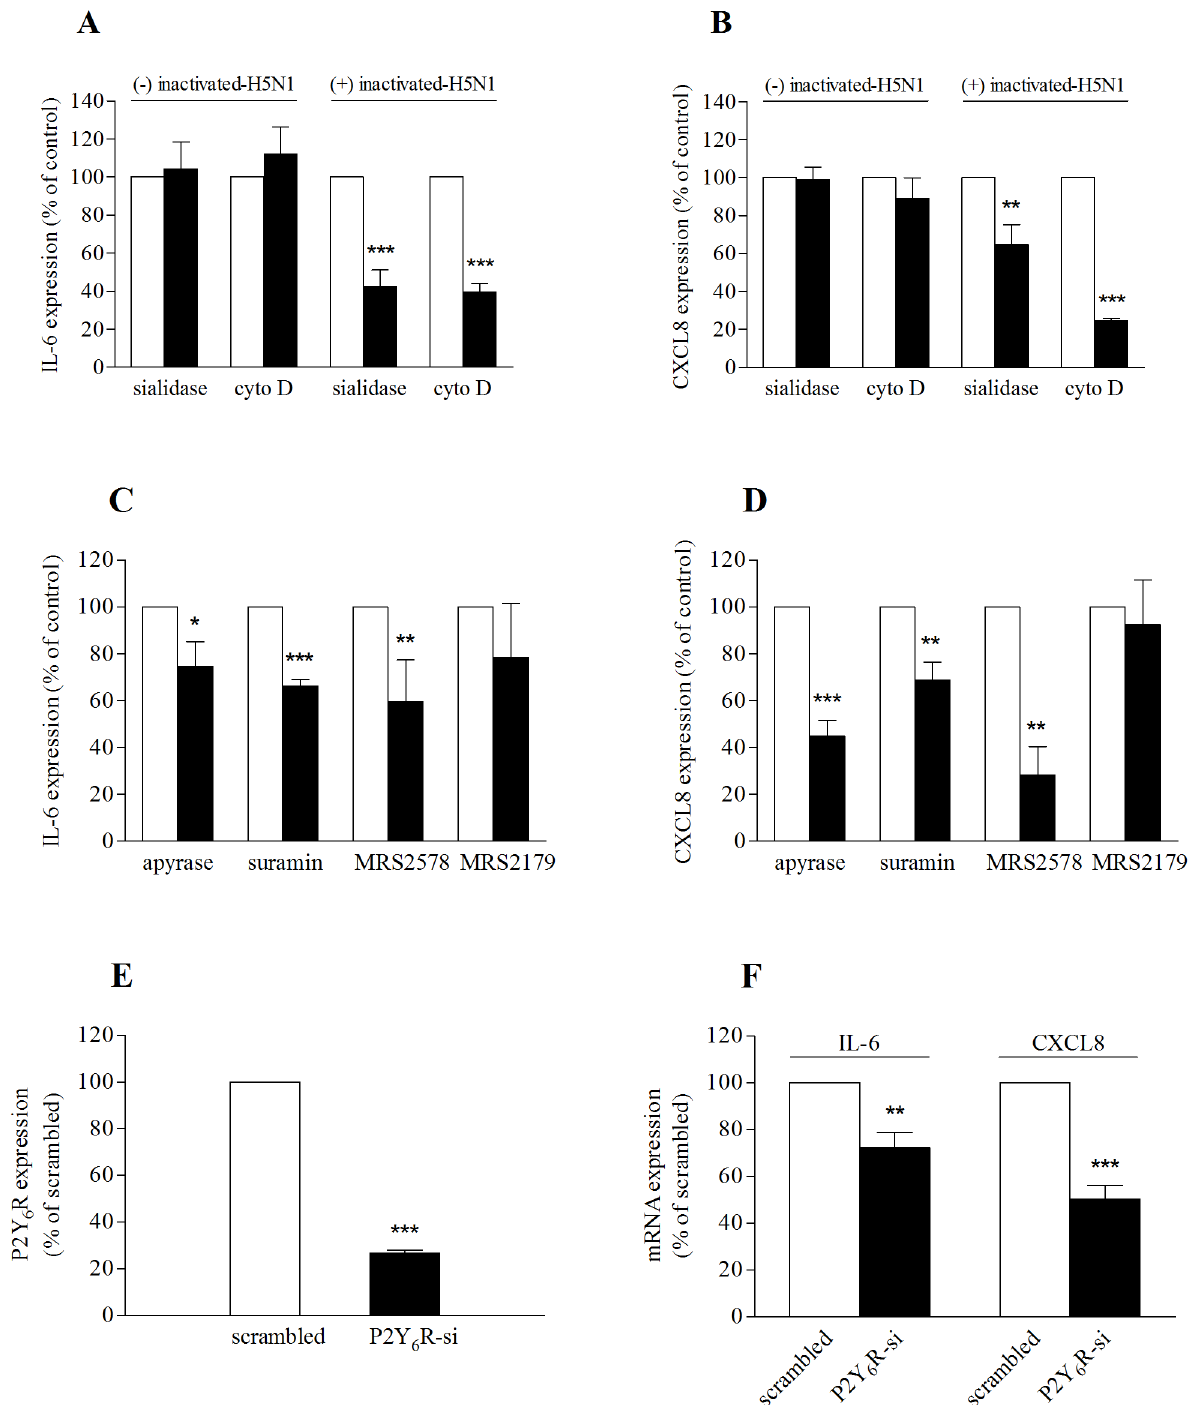
Fig 3. Effect of inactivated-H5N1 is mediated via P2Y 6 purinoceptors. The effect of inactivated-H5N1on IL-6 (A and C) and CXCL8 (B andD) mRNA expression.16HBE14o-cellswere incubatedwith vehicle(dimethyl sulfoxide(DMSO) or H 2 O as appropriate) as control, 1 U/ml sialidase, 2 μ M cytochalasin D (cytoD) (A andB) or with apyrase(2 U/ml), suramin (100 μ M), MRS2578 (10 μ M) or MRS2179 (20 μ M) (C and D) , for 1 hr before exposureto inactivated-H5N1.Three hours after treatment, cells were harvested for qRT-PCR. Data were normalized with corresponding controlgroups from the same batch of cells treatedwith inactivated-H5N1(open bars) and reportedas a percentage. (A and B) cells weretreated (+) or untreated (-) with inactivated-H5N1as indicated. (E) 16HBE14o-cells were transfected with siRNA directedagainstP2Y 6 R or a scrambled-siRNA(100 pmol). Forty-eight hours after transfection, cells were exposedto